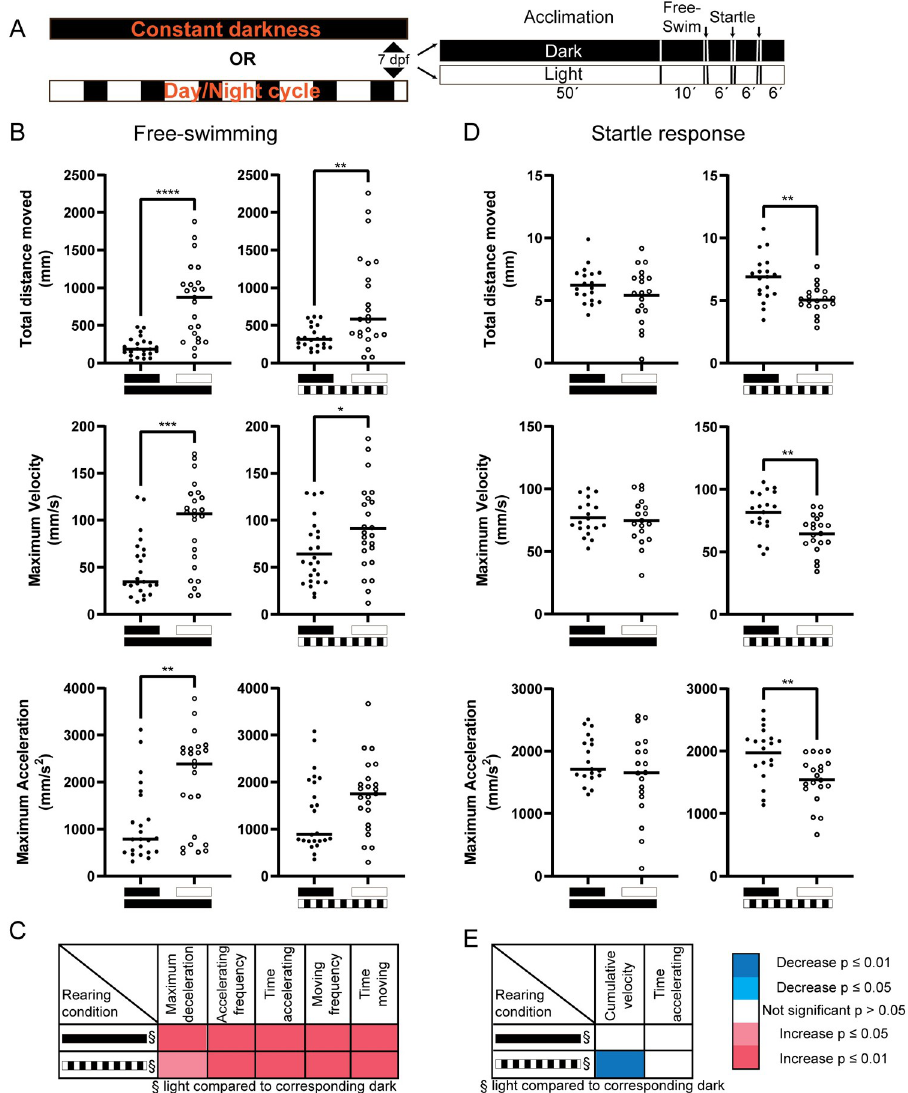
Fig 1. Larvae exhibit higher activity under light conditions. (A) Schematic of the experimental procedure. Embryos were kept under constant darkness (solid black bar) or a 14/10 h day/night cycle (striped bar) until the behavioral experiments. Each behavioral section had two components; free-swimming for 10 min under light (open circle; white) or dark (solid circle; black) conditions after a 50 min acclimation period under same illumination condition, and a set of startle responses (280 ms) where a sequence of three taps was executed with 6-minute interval; arrows designate timing of taps. (B, C) Both larvae housed under continuous darkness or a day/night cycle showed significantly more activity during free-swimming when tested under light conditions, compared to dark test conditions. (D, E) For larvae housed under continuous darkness we observed no differences in startle behavior, but larvae housed under a day/night cycle showed significantly lower activity during startle behavior when tested under light conditions, compared to dark test conditions. Free-swimming: n = 23–24 per group, startle response: n = 18–21 per group. Data is presented in scatterplots showing individual values and group mean or median. Significance: � p � 0.05, �� p � 0.01, ��� p � 0.001, ���� p � 0.0001.